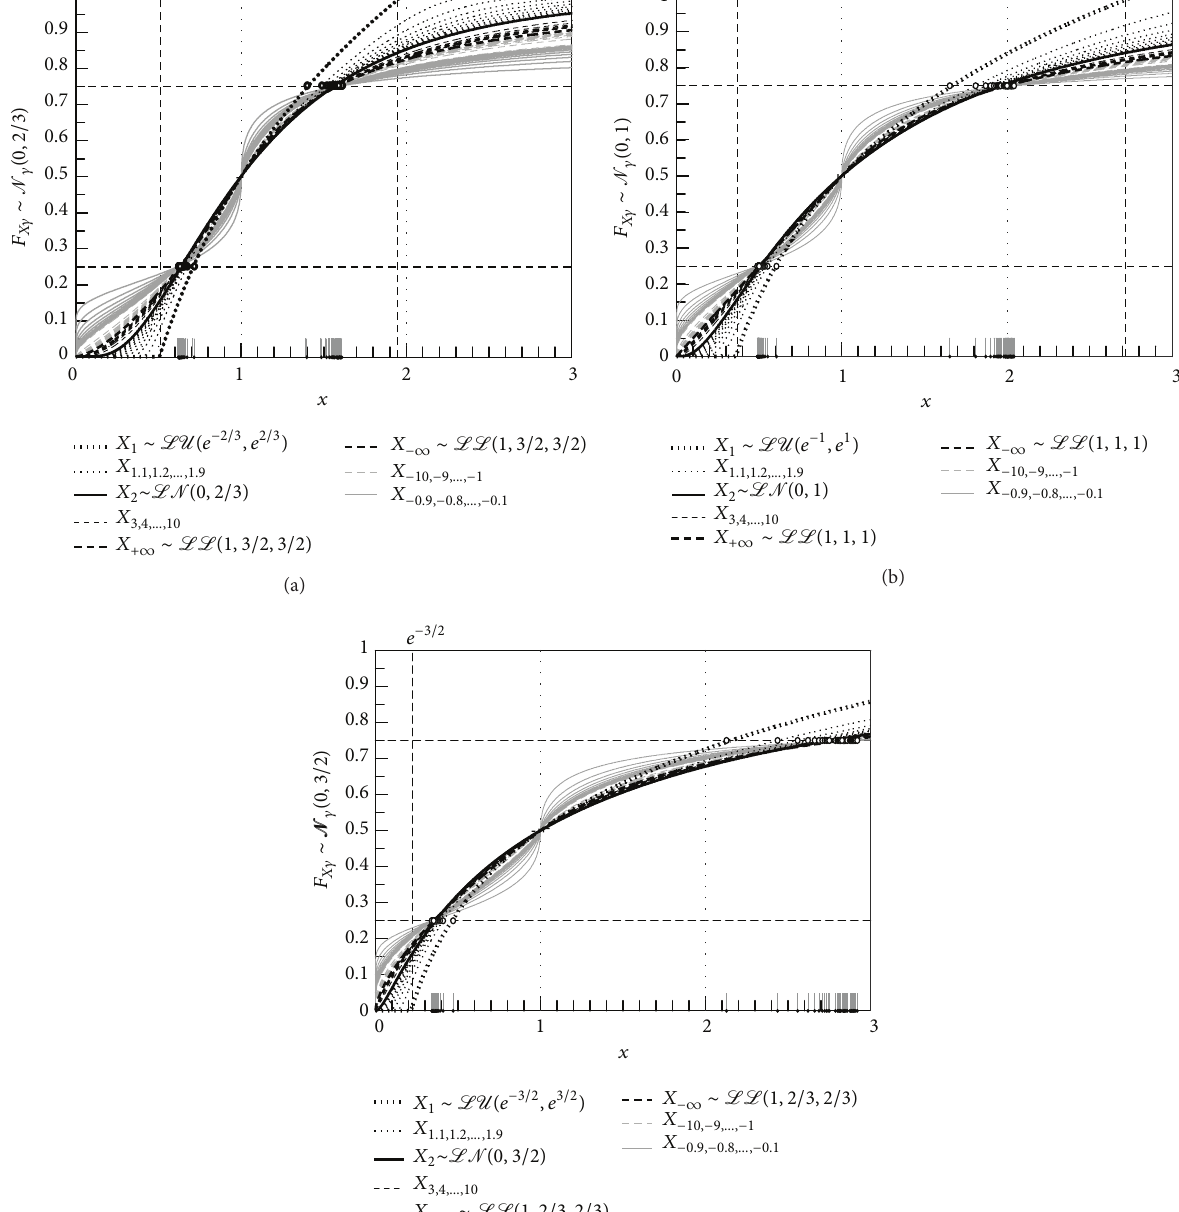
, 𝑋 𝛾 ∼ LN 𝛾 (0, 𝜎) , for 𝜎 = 2/3, 1, 3/2 , and various 𝛾 𝛾